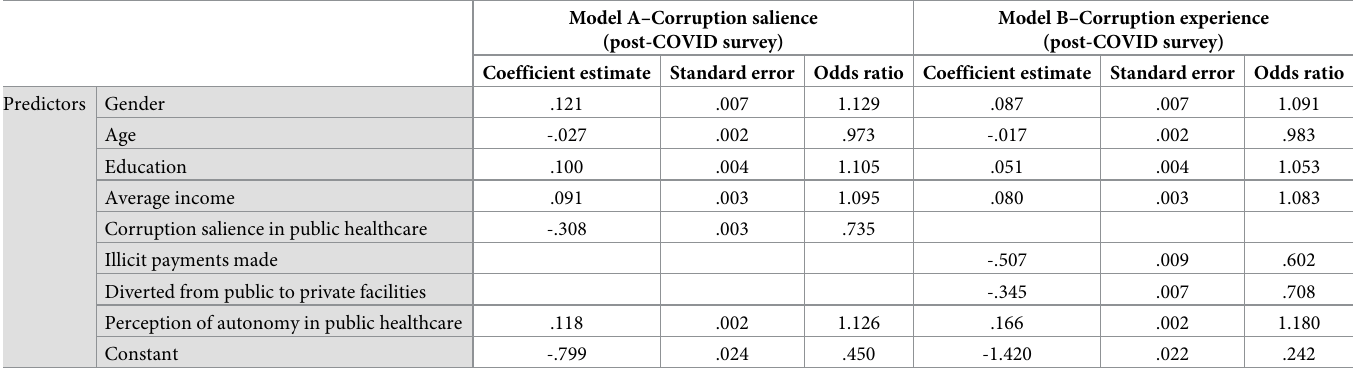
Table 4. Logistics regression results for the post-COVID